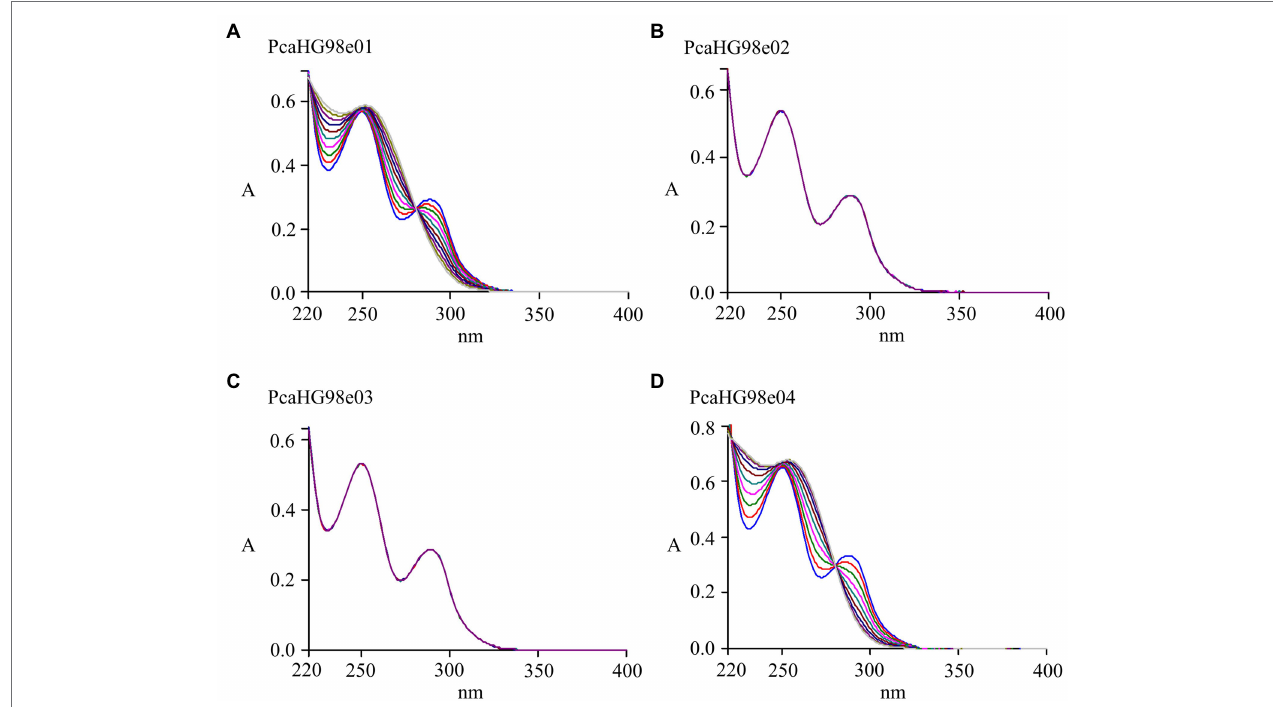
FIGURE 4 | Determination of pcaHG98 -encoded PCA 3,4 dioxygenase activity. Spectrophotometric changes during oxidation of PCA by pcaHG98 -encoded PCA 3,4 dioxygenase. The assay of PCA catalyzed by cell extracts from E . coli BL21 (DE3) carrying pET-28a- pcaHG98e01 (A) or pET-28a- pcaHG98e04 (D) . There was no enzyme activity in the cell extracts from BL21 (DE3) carrying pET-28a- pcaHG98e02 (B) or pET-28a- pcaHG98e03 (C)